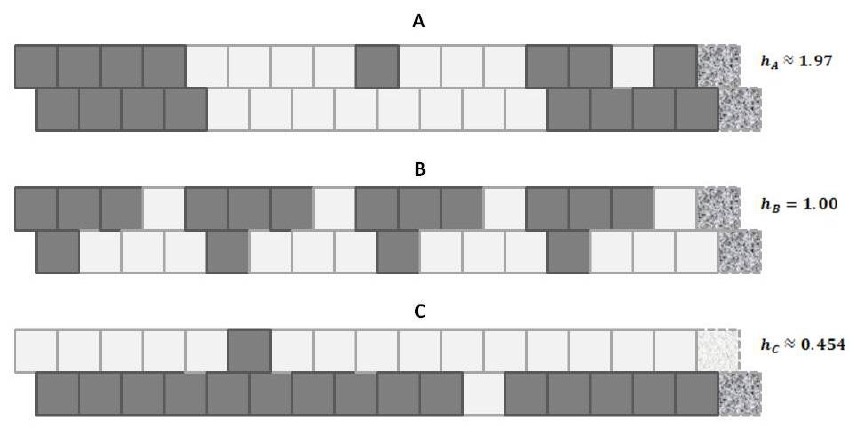
Figure 1. Three 1-D zigzag chains of 32 units each. The far right mottled units indicate wrap-around neighboring units from the far left; that is, the two units at the far right of each pattern (on the top and bottom rows) represent the two units at the farthest left; they are shown on the far right in order to make visualization of the nearest-neighbor, next-nearest-neighbor, and triplet clusters easier. In patterns A and B, the two units on the far right are mottled dark grey, corresponding to the two leftmost units that are shown in dark grey. In pattern C, the uppermost unit on the far right is shown in mottled light grey, corresponding to the light grey uppermost unit on the far left of pattern C. The dark grey mottling of the far-right unit on the bottom row of pattern C corresponds to the dark grey unit on the far left bottom row. Each pattern (A–C) has equiprobable on (state A ) and off (state B ) units. The three patterns can be described as: (A) ferromagnetic-like, with one inserted non-like unit in each domain; (B) a set of four eight-unit patterns with an equilibrium distribution of configuration triplets (achieved when the nearest-neighbor interaction energy is 0); and (C) anti-ferromagnetic-like, with one inserted like-near-like (ferromagnetic) unit of each type. In each case, the nearest-neighbor connection is read as the diagonal between two units. The parameter h (far right) indicates the nature and strength of pairwise interactions. Computation of the h parameter values for the above figure (and related discussion) is given in the following Section 5. In particular, the h -values are explained in detail in Figure 5 and in the corresponding